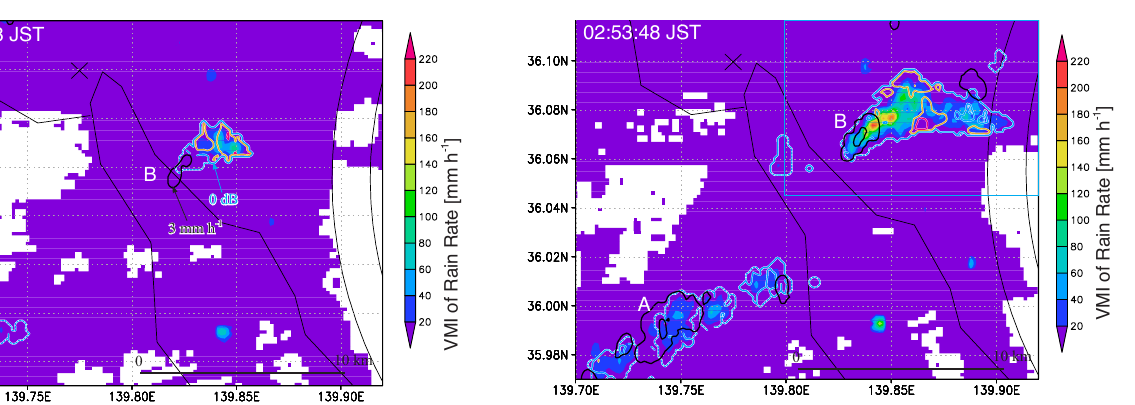
Fig. 10. Horizontal distribution of the vertical maximum inten- sity of differential reflectivity, VMI( Z DR ), and the surface rain- Figure 10. Horizontal distribution of the vertical maximum intensity of differential reflectivity, VMI( Z DR ), and the surface rainfall rate superimposed over the vertical maximum intensity of the fall rate superimposed over the vertical maximum intensity of the rainfall rate, VMI( R ), estimated from the MRI C-band polarimetric radar at 02:49 JST. Thick rainfall rate, VMI( R ), estimated from the MRI C-band polarimet- black contours indicate the surface rainfall rate at 3 mm h -1 and 18 mm h -1 . Solid colored contours indicate VMI( Z DR ) at altitudes above the freezing level from 0 dB with a contour interval of 3 dB, ric radar at 02:49JST. Thick black contours indicate the surface and dashed-blue contours depict VMI(Z DR ) located at altitudes less than the freezing level at 0 dB. rainfall rate at 3mmh − 1 and 18mmh − 1 . Solid colored contours (cid:51)(cid:68)(cid:85)(cid:87)(cid:76)(cid:68)(cid:79)(cid:3)(cid:70)(cid:76)(cid:85)(cid:70)(cid:79)(cid:72)(cid:86)(cid:3)(cid:82)(cid:81)(cid:3)(cid:87)(cid:75)(cid:72)(cid:3)(cid:85)(cid:76)(cid:74)(cid:75)(cid:87)(cid:3)(cid:76)(cid:81)(cid:71)(cid:76)(cid:70)(cid:68)(cid:87)(cid:72)(cid:3)(cid:87)(cid:75)(cid:72)(cid:3)(cid:82)(cid:69)(cid:86)(cid:72)(cid:85)(cid:89)(cid:68)(cid:87)(cid:76)(cid:82)(cid:81)(cid:3)(cid:71)(cid:72)(cid:192)(cid:70)(cid:76)(cid:87)(cid:3)(cid:85)(cid:72)(cid:74)(cid:76)(cid:82)(cid:81)(cid:3)(cid:68)(cid:87)(cid:3)(cid:68)(cid:81)(cid:3)(cid:72)(cid:79)(cid:72)(cid:89)(cid:68)(cid:87)(cid:76)(cid:82)(cid:81)(cid:3)(cid:68)(cid:81)(cid:74)(cid:79)(cid:72)(cid:3)(cid:82)(cid:73)(cid:3)(cid:19)(cid:17)(cid:24)(cid:131)(cid:3)(cid:73)(cid:82)(cid:85)(cid:3) reference. indicate VMI( Z DR ) at altitudes above the freezing level from 0dB with a contour interval of 3dB, and dashed-blue contours depict VMI( Z DR ) located at altitudes less than the freezing level at 0dB. Partial circles on the right indicate the observation deficit region at an elevation angle of 0.5 ◦ for reference.